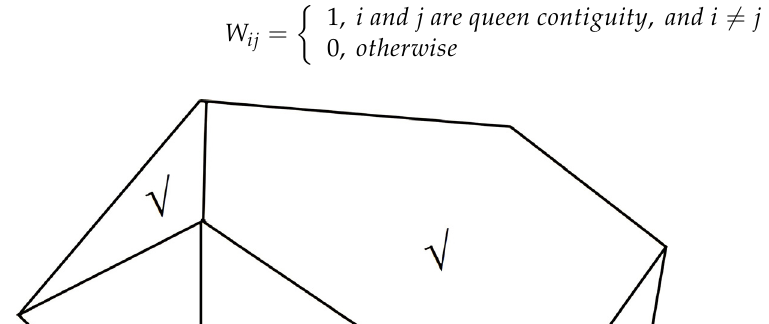
Figure 4. Diagram of queen contiguity. Spillover effect areas are marked with a “ √ ”.